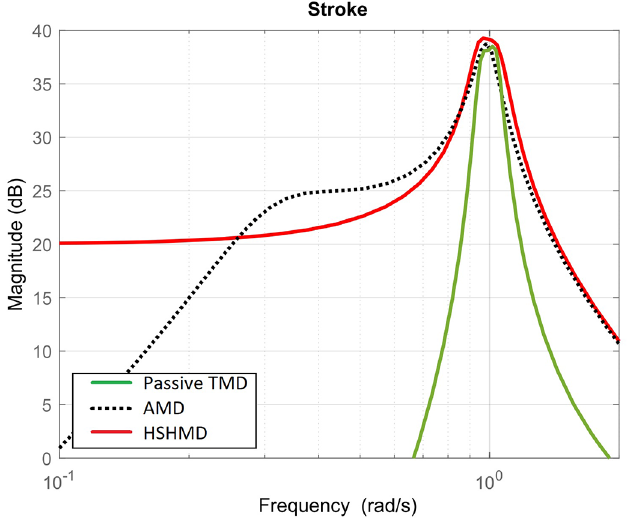
Fig. 7. Stroke comparison depending on the device (Green: Passive TMD. Black dotted line: AMD. Red line: HSHMD).